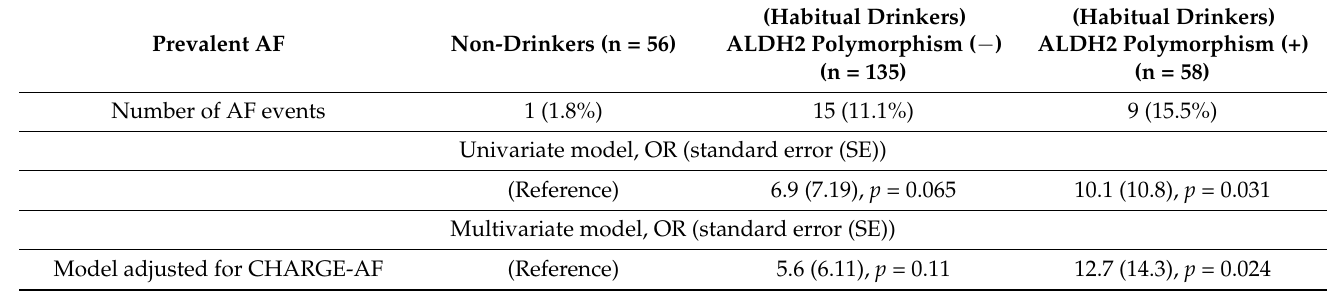
Model adjusted for